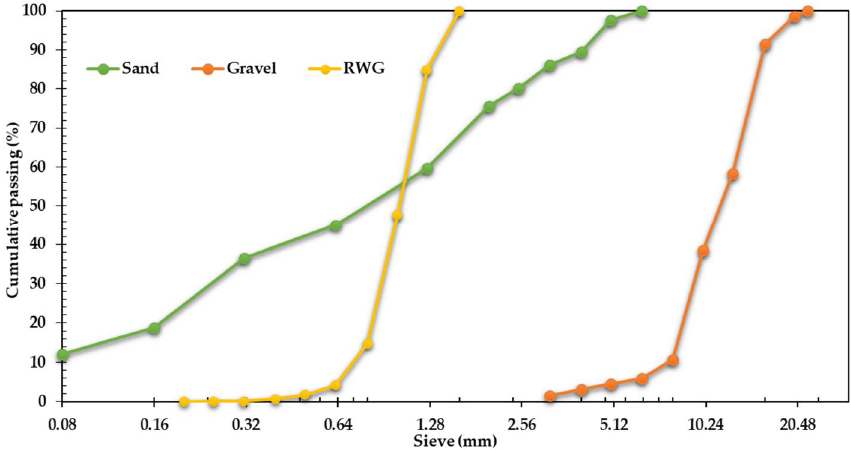
Figure 1. Waste recycled glass: ( a ) waste glass, ( b ) RWG particles with different colors, ( c ) and ( d ) size of the RWG particle.